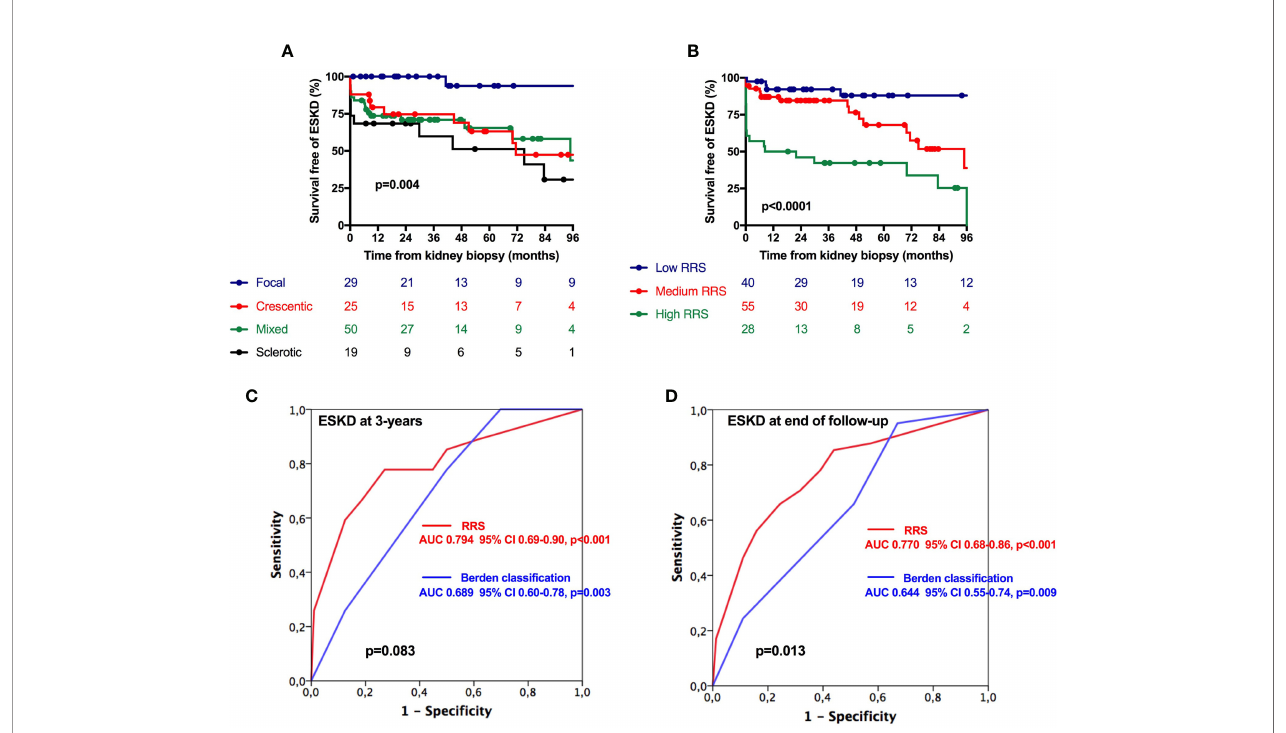
FIGURE 2 | Renal survival in the ESKD cohort according to Berden classi fi cation and Renal risk score. (A) Survival free of ESKD according to Berden classi fi cation and (B) Renal Risk Score. (C, D) Area under the curve of Renal Risk Score (red line) and Berden classi fi cation (green line) for ESKD prediction at 3 years (C) and at the end of follow-up (D) . Survival curves were performed using Kaplan – Meir method, and comparisons between curves were done using the log-rank test. Black p- values indicate AUC comparisons of Berden classi fi cation and RRS. AUC, area under the curve; RRS, renal risk